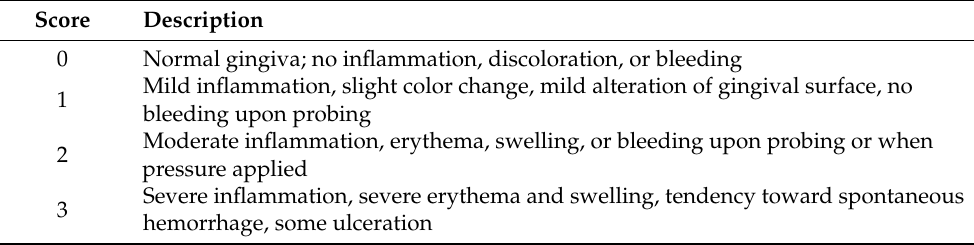
Table 3. Gingivitis index (GI) according to the modified Talbott method [17]. Score